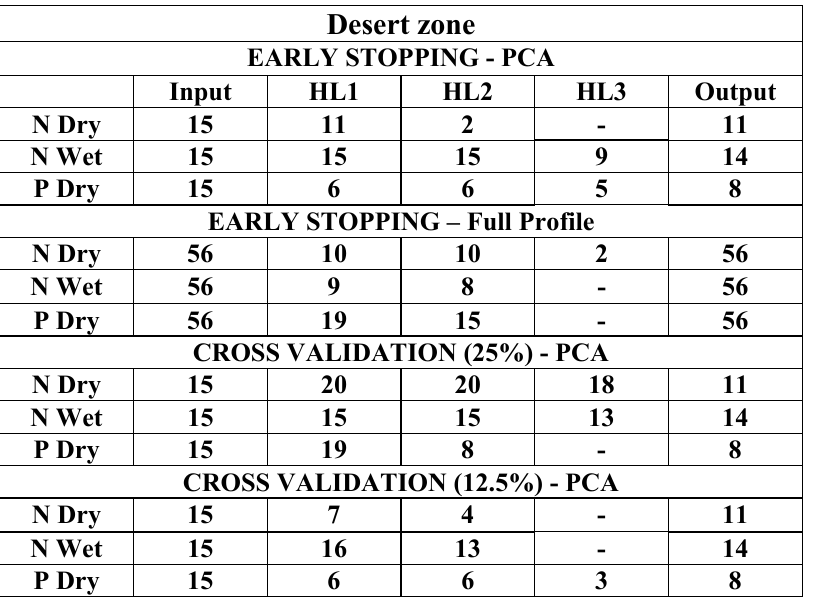
Table 1. Best neural network topologies over desert zone obtained for each neural network approach: input, HL1, HL2, HL3 and output columns report the number of neurons for the input, hidden layer 1, hidden layer 2, hidden layer 3 and output, respectively. Each approach employs 3 neural networks, named N Dry (for dry refractivity estimation), N Wet (for wet refractivity estimation) and P Dry (for dry pressure